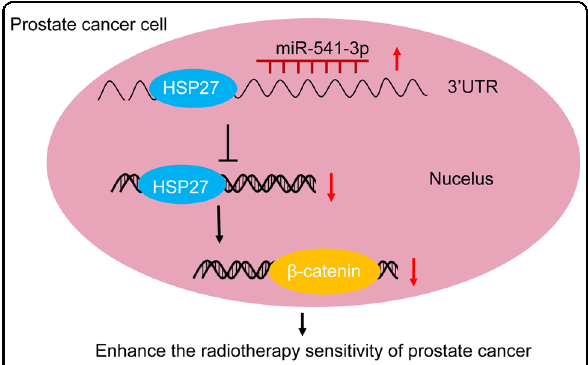
Fig. 6 The molecular mechanism diagrams. miR-541-3p-mediated inhibition of HSP27 enhances the radiosensitivity of PCa cells by downregulating the expression of β